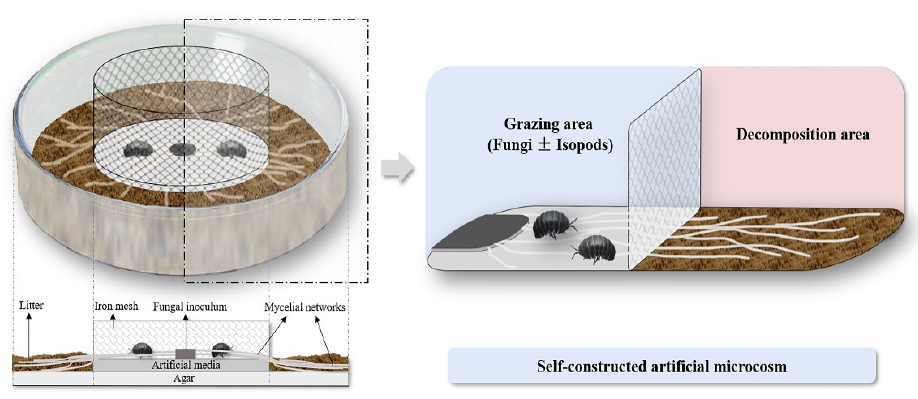
Figure 1. The artificial